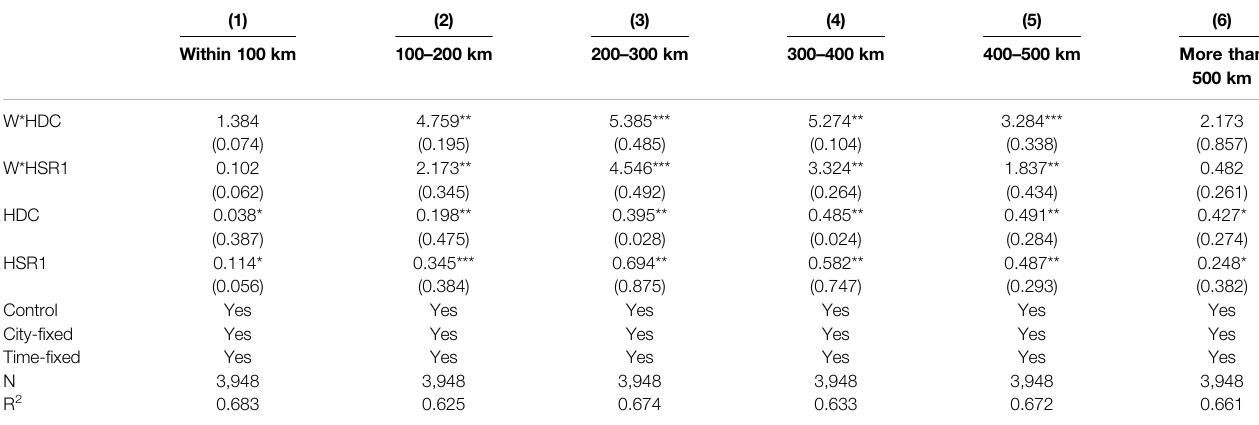
TABLE 9 | Spatial radius of the spatial spillover